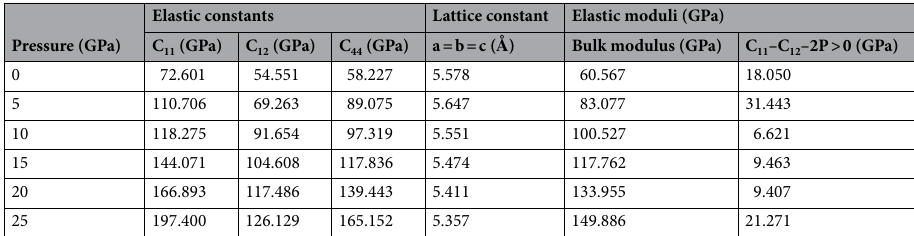
Table 1. Elastic moduli and lattice parameters along with stability criteria computed under the influence of pressure from 0 to 25 GPa.